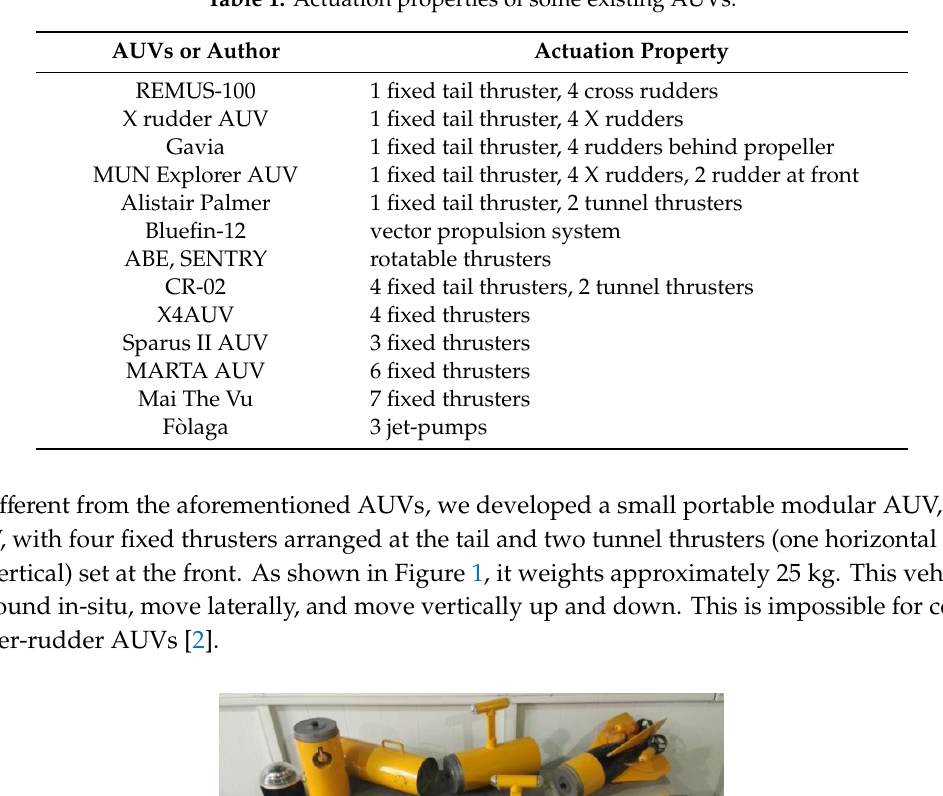
Table 1. Actuation properties of some existing AUVs.